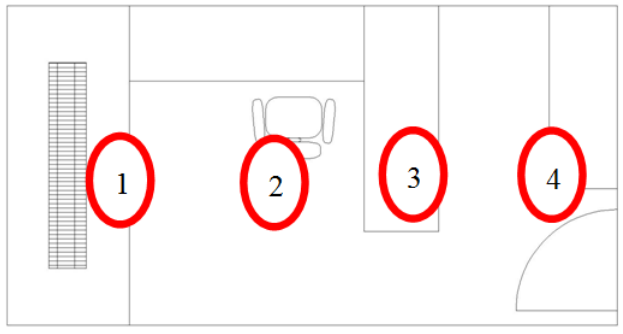
Figure 8. Placement of the sensors for temperature measurement (red marks).